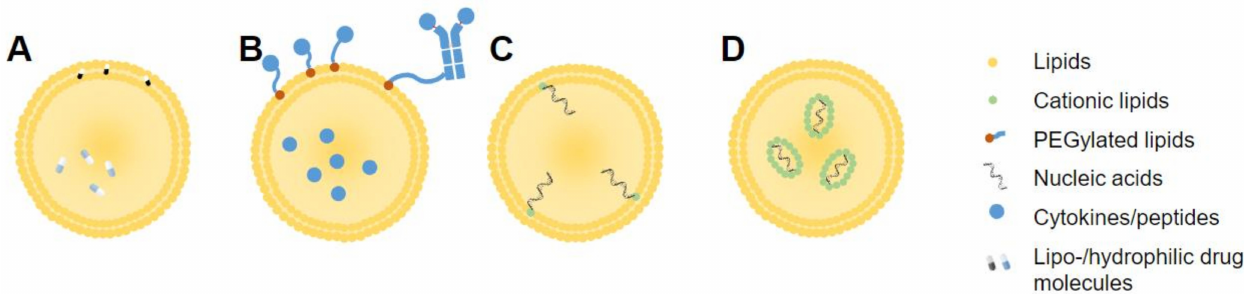
Figure 4. Simplified locations of incorporated or conjugated agents, including ( A ) drug molecules, ( B ) cytokines/peptides, or ( C ) nucleic acids in liposome or ( D ) solid lipid nanoparticle